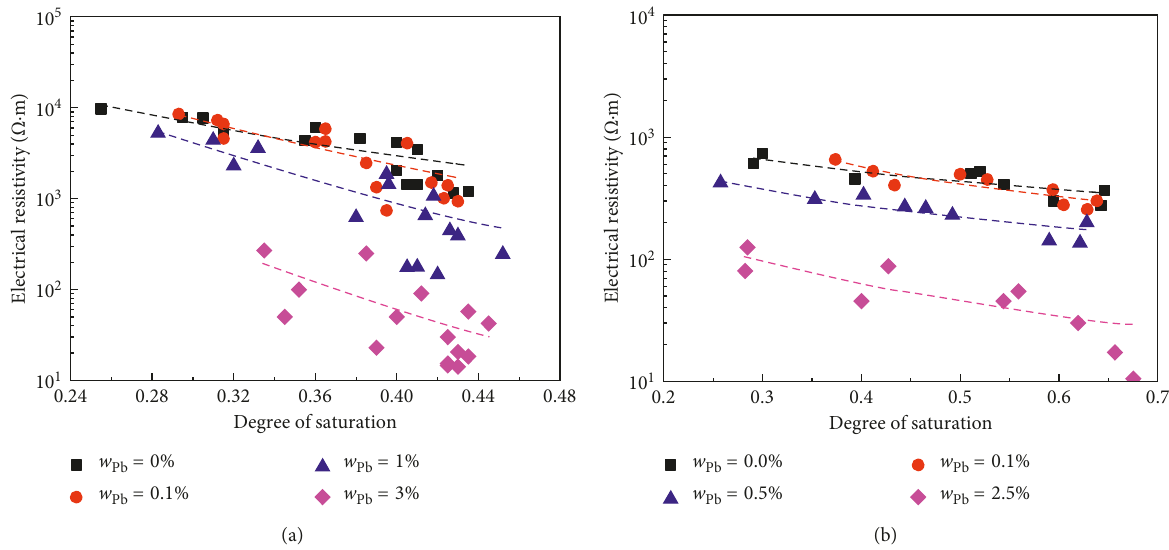
Figure 6: Variation of electrical resistivity with degree of saturation: (a) specimens of soil S1; (b) specimens of soil S2.